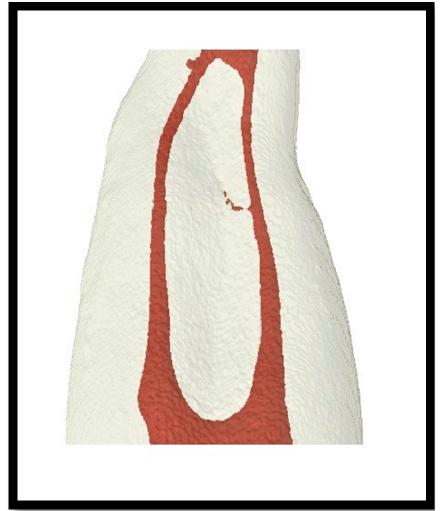
Figure 13. Micro-CT image showing the middle third location of the accessory canal.